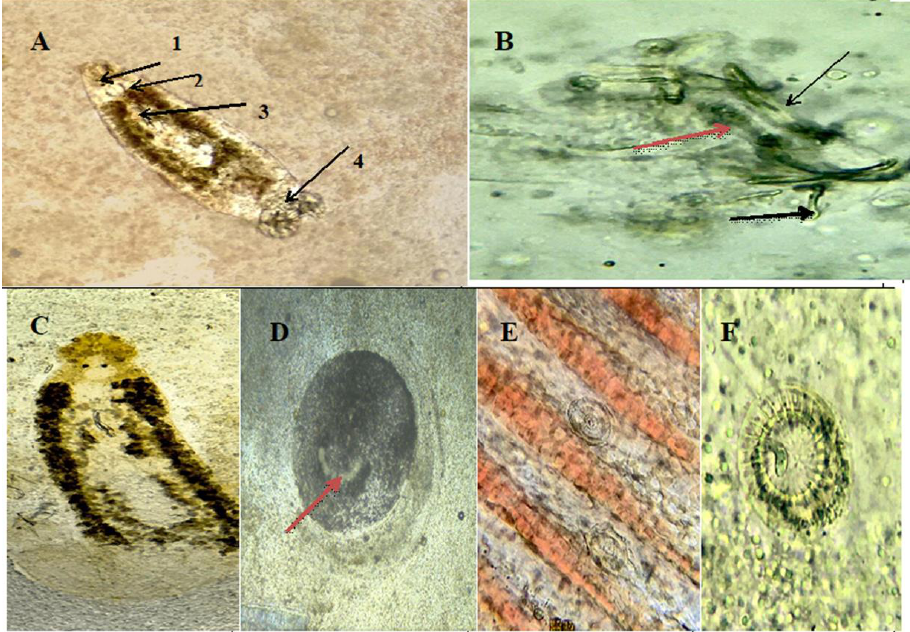
Figure 1. Wet mount of gill filament showing: ( A ) Cichlidogyrus spp. adult stage ×100 (1 — eyespots, 2 — pharynx, 3 — copulatory organ, 4 — opisthaptor); ( B ) opisthaptor of Cichlidogyrus spp. ×400 (red arrow shows dorsal anchor; black arrow shows ventral anchor; heavy dark arrow shows marginal hooks; ( C ) Dactylogyrus spp. adult stage ×100; ( D ) Ichthyophthirius multifiliis trophont ×1000 (arrow shows horseshoe-shaped nucleus); ( E ) Trichodina spp. ×100; ( F ) Trichodina sp . ×400. 3.5. Prevalence of Endoparasites in Relation to Sex, Size and Seasonal Condition in Nile Tilapia As presented in Table 4, the infection rate of digenean trematodes was 3% (9 of 300); all of the infected samples were males and the infection was detected only in the summer season. Longer and heavier fish tended to be more susceptible to digenea infection. The infection rate of acanthocephala was 25% (females, 52%; males, 48%); however, infection with acanthocephala was significantly affected by the season, with the highest rate of in- fection (52%) observed in summer. The overall prevalence of internal protozoa was 11%. Table 4. Prevalence of endoparasites in relation to sex, size and seasonal condition in Nile tilapia. Variable Non-Infected ( n = 291)